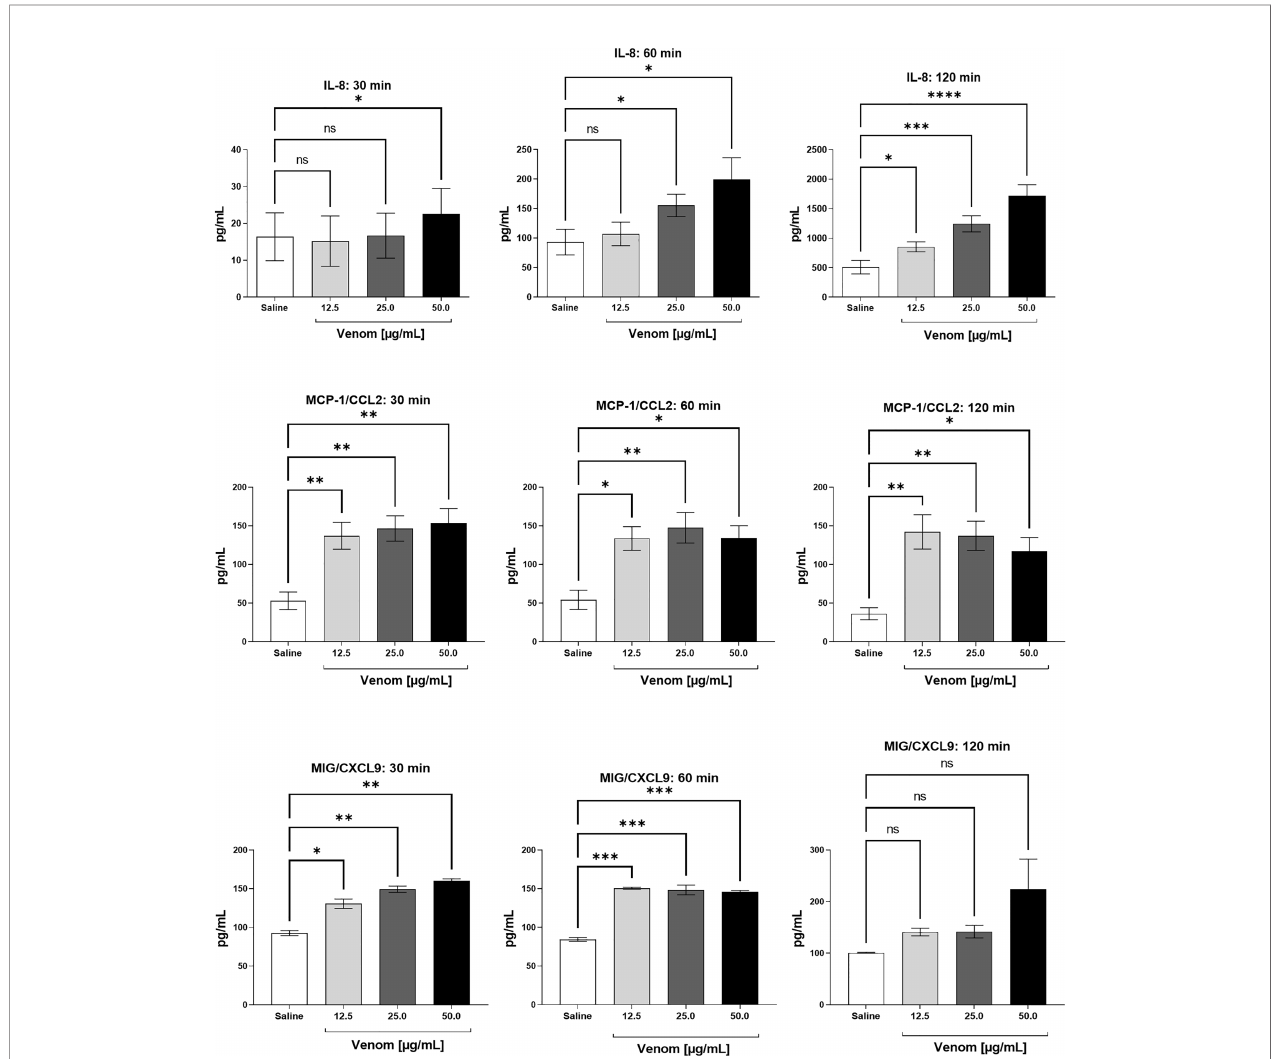
FIGURE 4 | Chemokine levels in human plasma after treatment with B. jararaca venom. Human blood samples containing GPRP (8 mg/mL) were incubated with increasing concentrations of B. jararaca venom or sterile saline solution for 30, 60 and 120 minutes at 37°C. After plasma collection and dilution (1:2), the presence of chemokines was evaluated by cytometric bead array (CBA). The results are represented as the mean ± SEM of duplicates from three independent tests. ns, not signi fi cant; * p ≤ 0.05, ** p ≤ 0.005, *** p ≤ 0.0005, **** p <